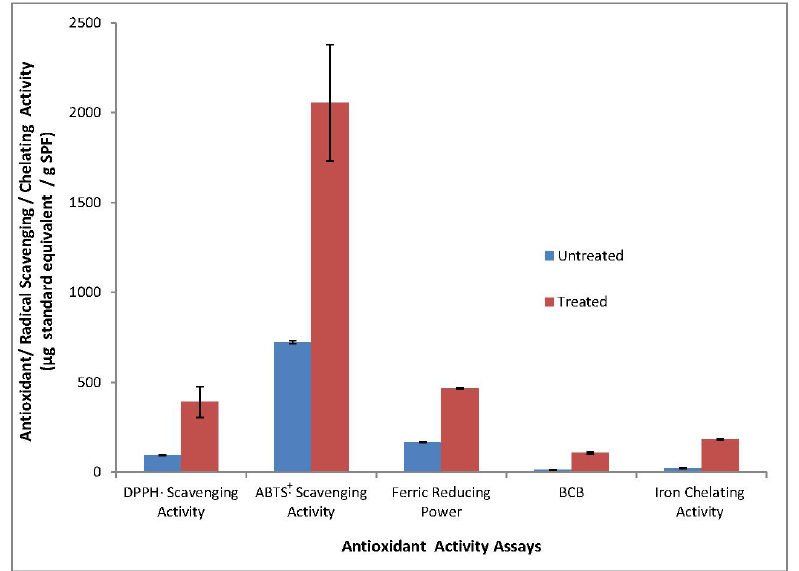
Figure 1. Antioxidant activity of SPF as affected by simulated gastrointestinal pH conditions. Results obtained from means of three determinations ± standard